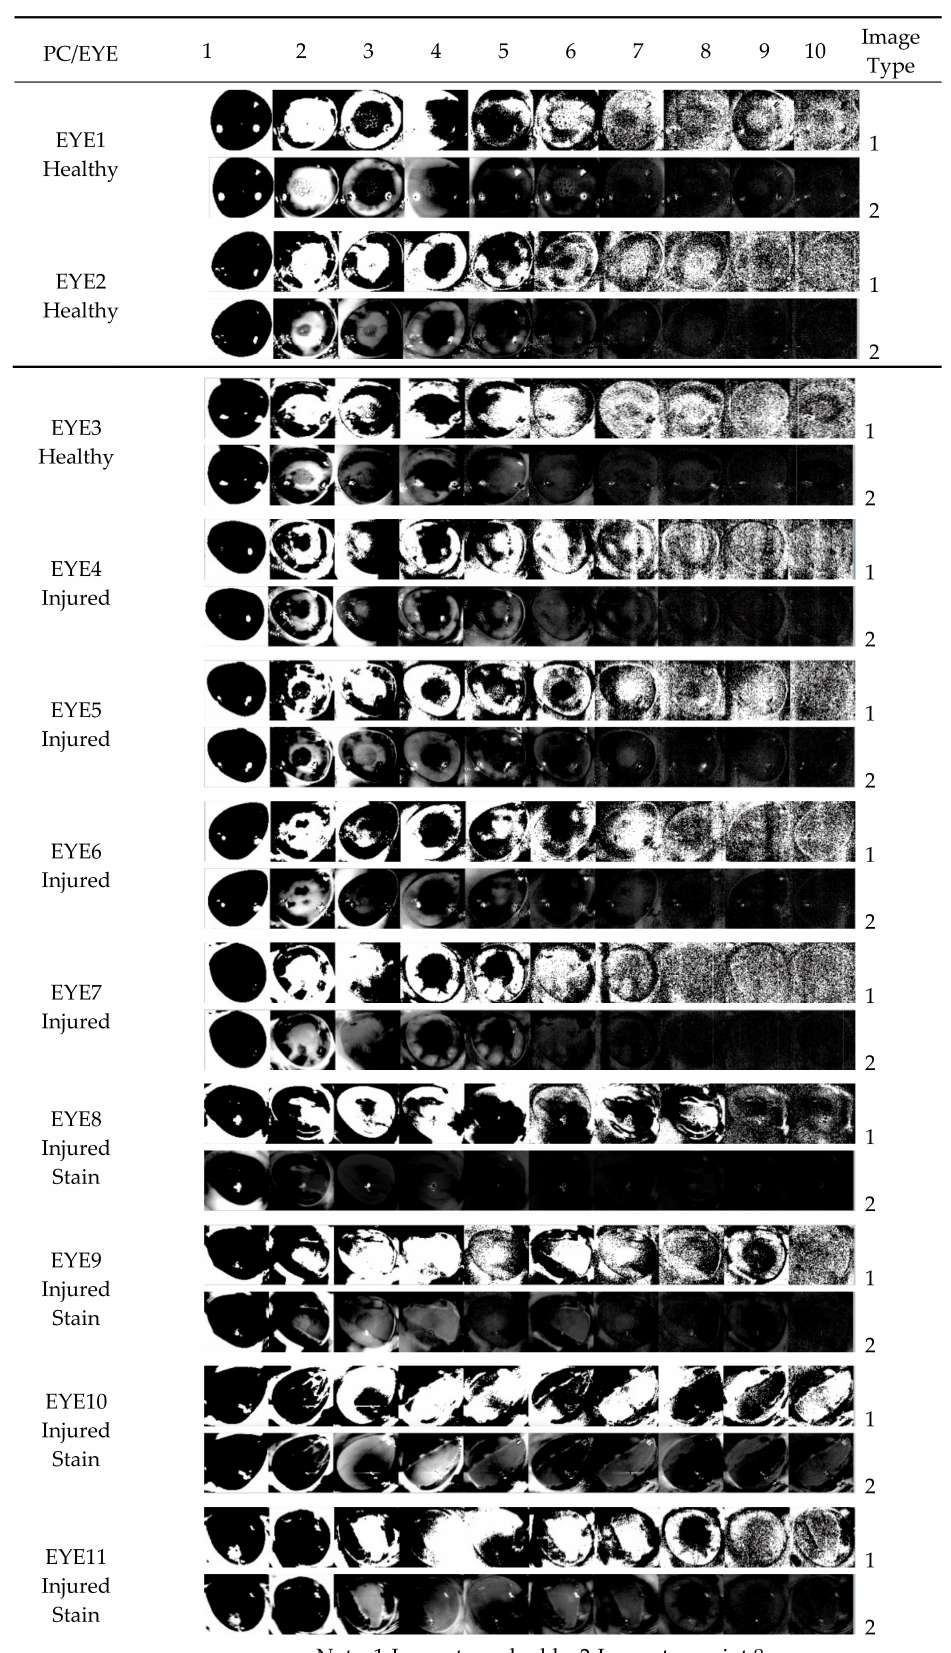
Figure 11. Ten principal components (PC) of eleven eyes transformed with PCA. The clinical information appears in several PC for EYE8 until EYE11 as these images were stained. In contrast, EYE1 to EYE7 which were without stained appear similar even though EYE4 to EYE7 had abnormal corneal